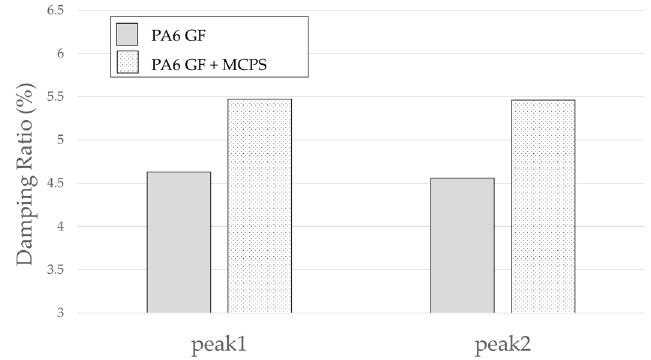
Figure 7. Effects of MCPs on damping ratio of plate specimen.